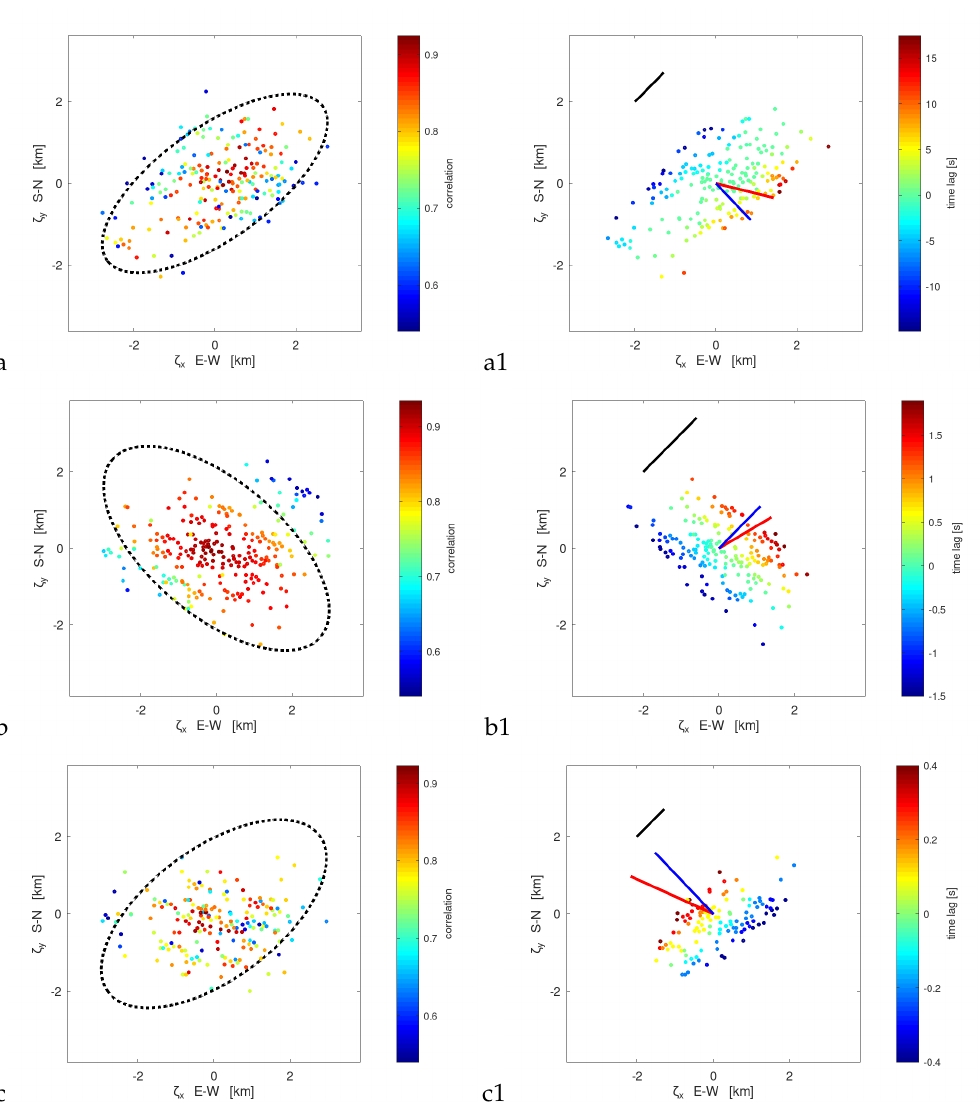
Figure 9. Correlations for zero time lag as a function of separation vector for datasets: ( a )—547449, ( b )—L547785, ( c )—L552177, with quadratic form ellipsis overlaid; time lag for maximum of cross- correlation as a function of separation vector for datasets: ( a1 )—547449, ( b1 )—L547785, ( c1 )—L552177, with velocity estimates: red - taking into account anisotropy of structures; blue - isotropic. Black vectors indicate velocities with magnitude: 100 m/s, 1000 m/s, 1000 m/s for sets 547449, L547785, and L552177,